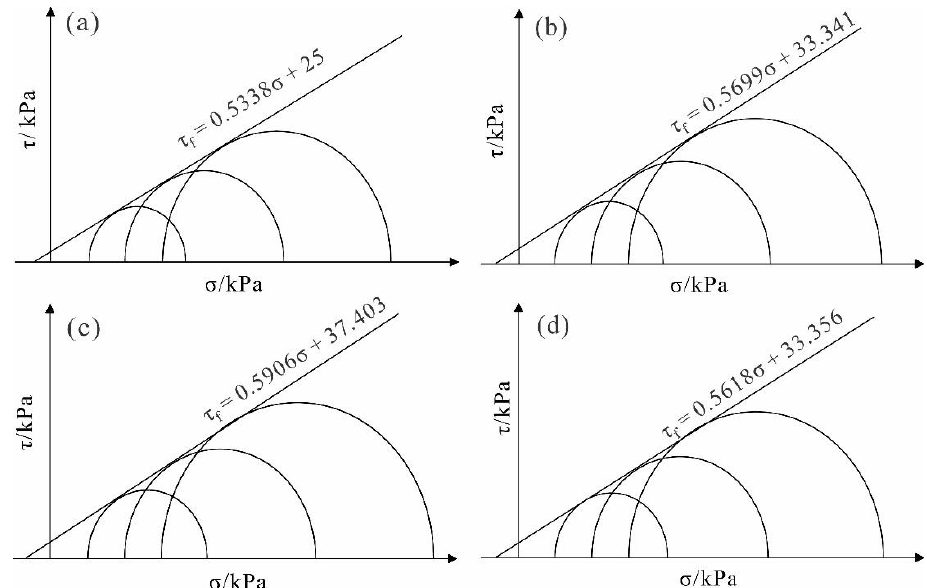
Figure 9. Stress Mohr circles of samples under different stabilizer concentrations: ( a ) 0%; ( b ) 0.4%; ( c ) 0.6%; ( d ) 0.8%.